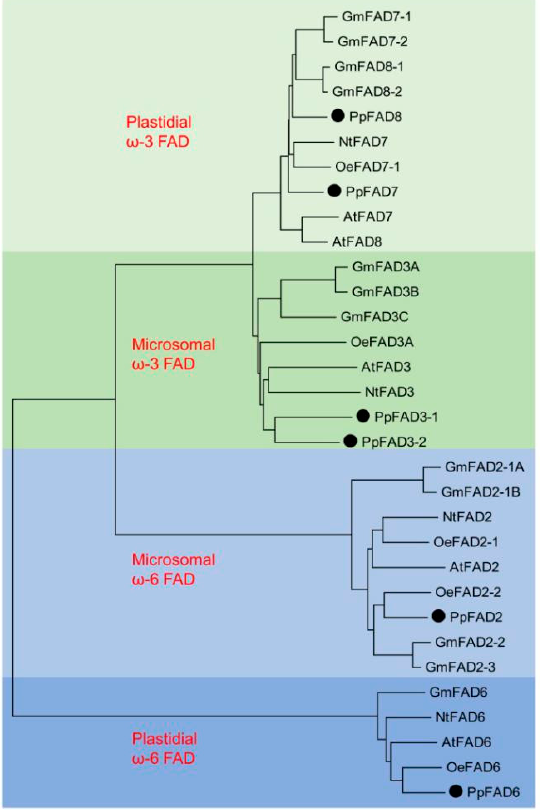
Figure 2. Phylogenetic tree of plant fatty acid desaturases (FAD) showing clustering within the four major FAD groups. Alignments were calculated with ClustalW, and the analysis was performed using the Neighbor-Joining method. FAD groups are indicated by different colors, light green for plastidial ω -3 group, green for microsomal ω -3 group, light blue for microsomal ω -6 group, and blue for plastidial ω -6 group. Peach FADs are shown with black dots.